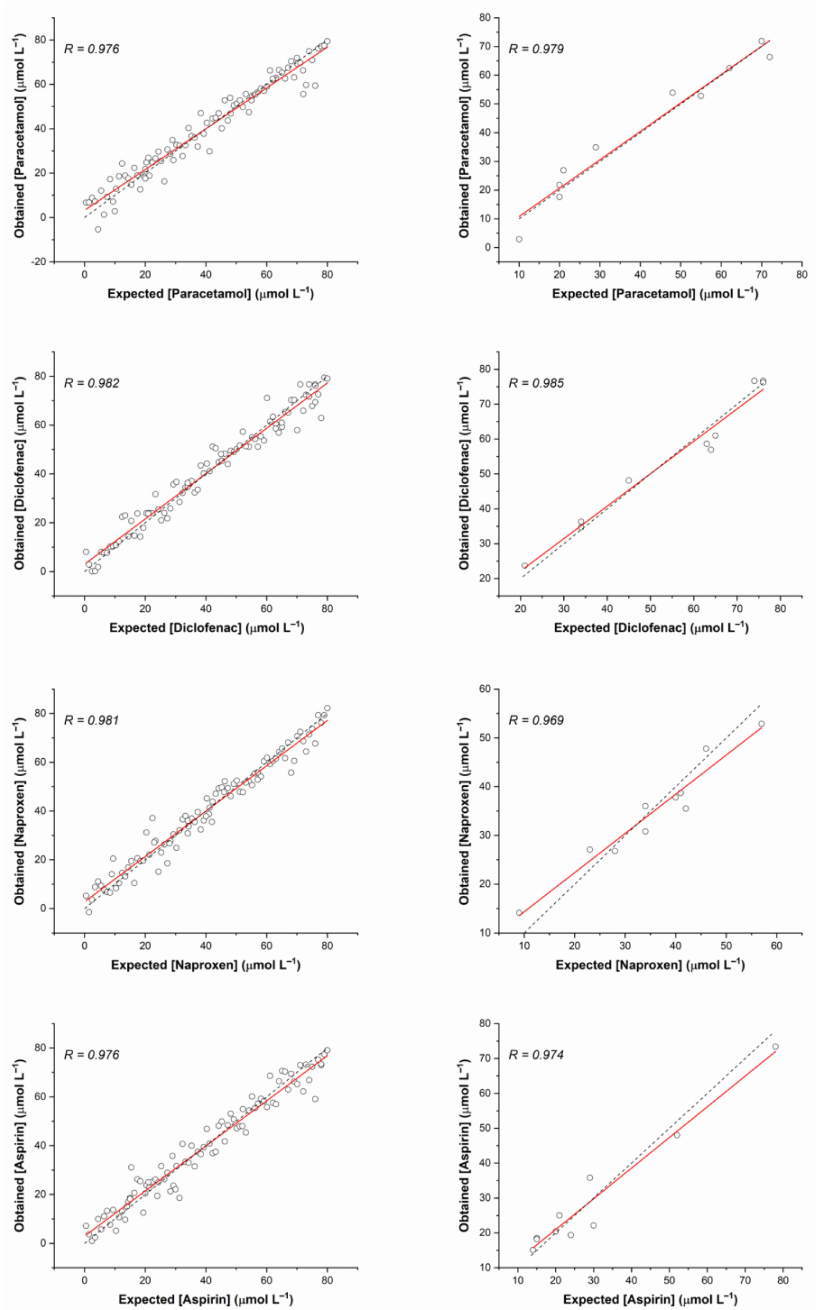
Figure 9. Obtained vs. expected concentration of NSAIDs using MLP. The solid line in each graph corresponds to the regression of data (correlation coefficient R). The plots on the left indicated the training set and on the right the testing